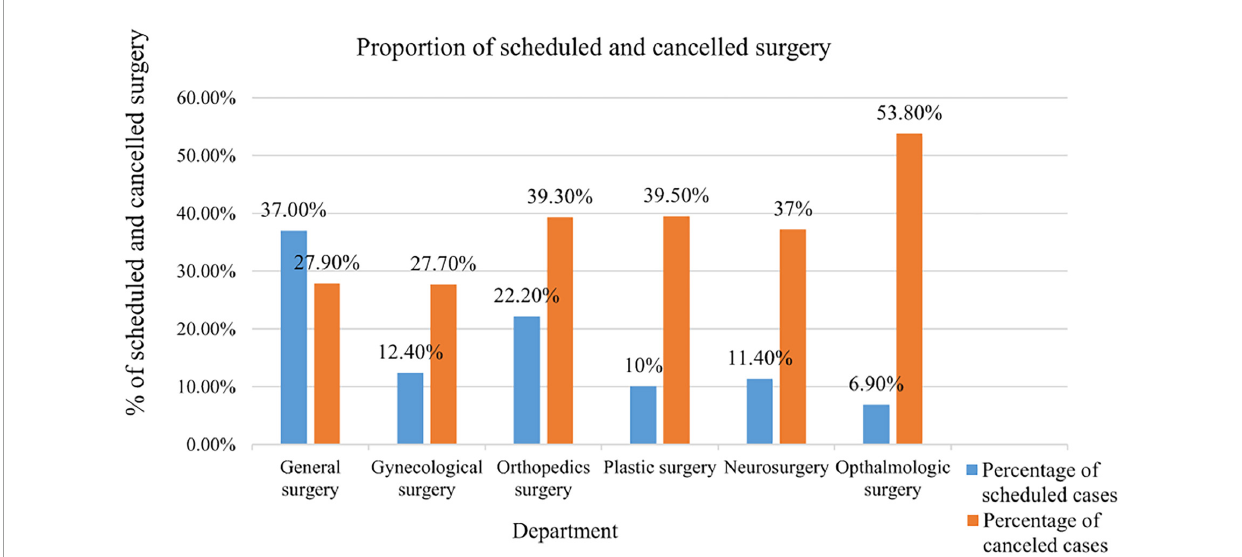
FIGURE1 Proportion of scheduled and canceled surgery by the department in public hospitals in Harari regional state, Eastern Ethiopia, 2021 ( n = 378).